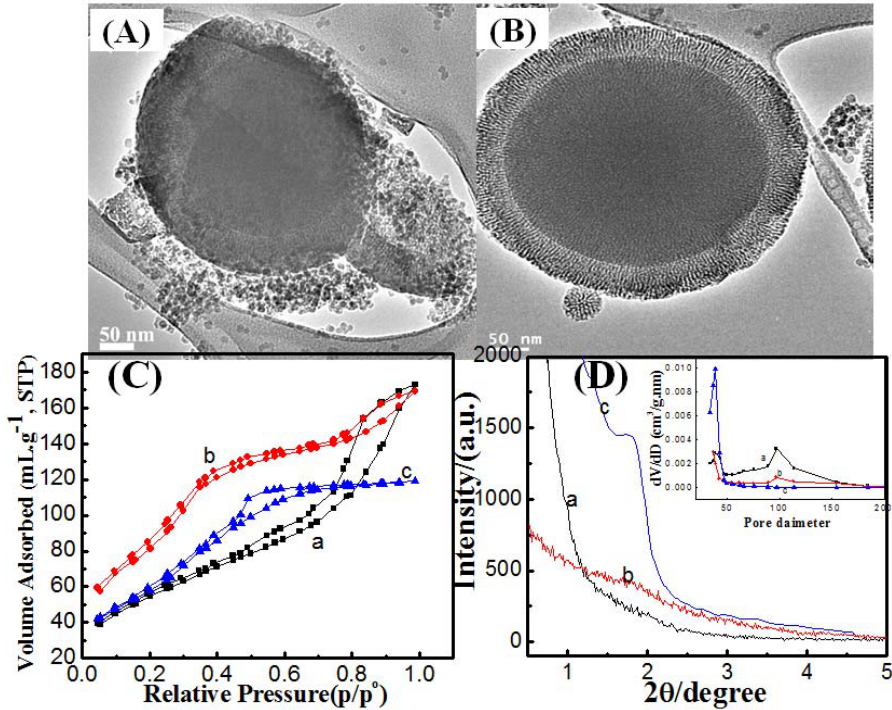
Figure 3. TEM images for mesoporous silica shell constructed on silica cores by two-pot route at synthesis time ( A ) 6 h and ( B ) 2 h at 50 °C; ( C ) N isotherms and ( D ) low X-ray diffraction patterns for mesoporous silica shell constructed on silica cores by two-pot route at synthesis time ( a ) 20, ( b ) 6 and ( c ) 2 h at 50 °C and pore-size distribution from the adsorption branch